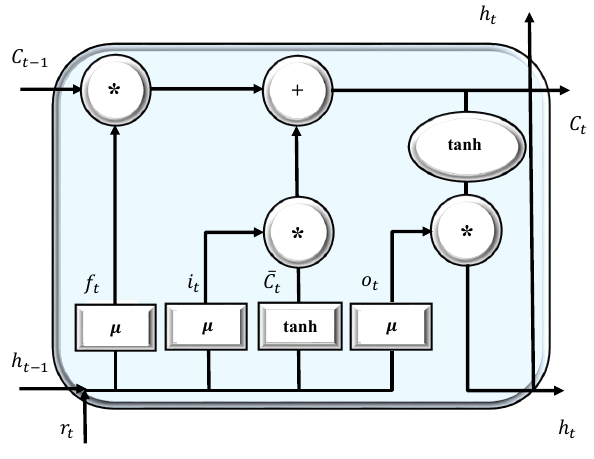
Figure 2. The LSTM cell